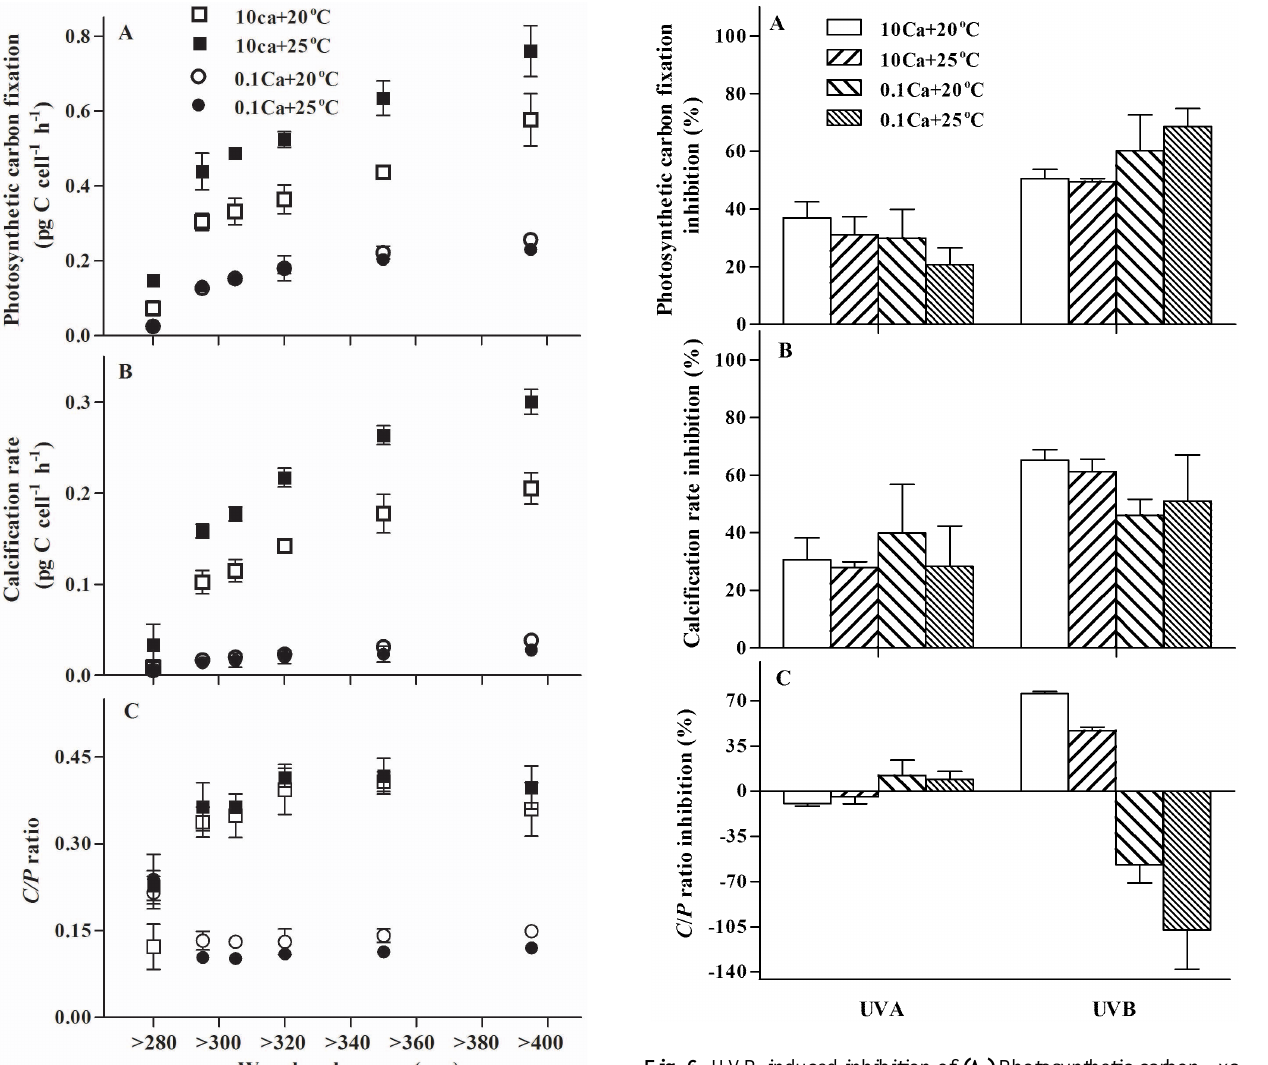
Fig. 6. UVR-induced inhibition of (A) Photosynthetic carbon fixa- tion, (B) Calcification rate and, (C) C / P ratio of Emiliania huxleyi cells. The lines on top of the bars represent the standard deviations ( n =